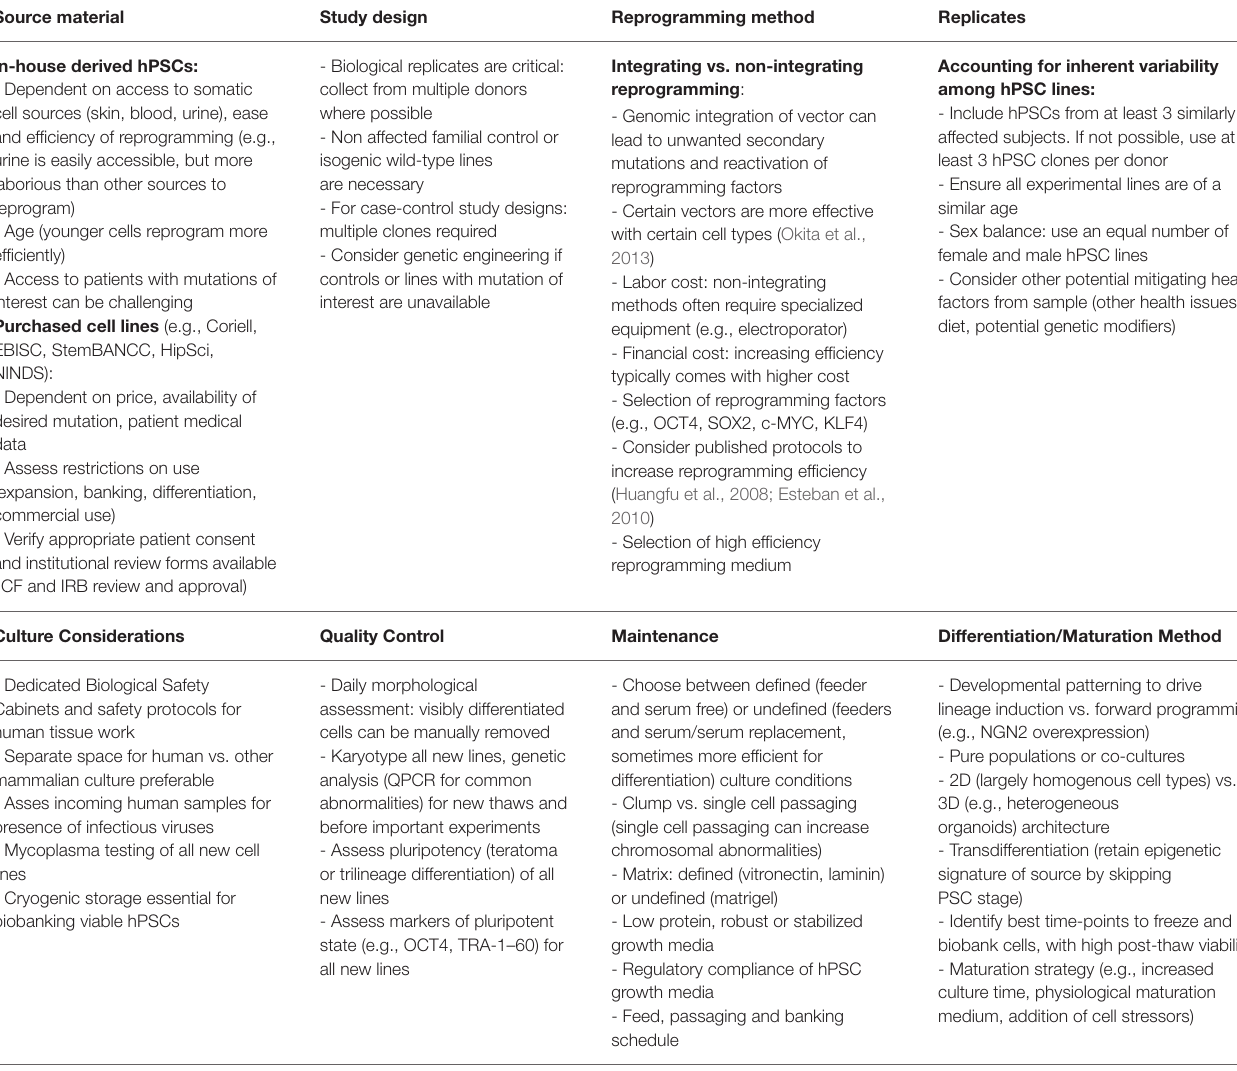
TABLE 2 | Considerations for PSC